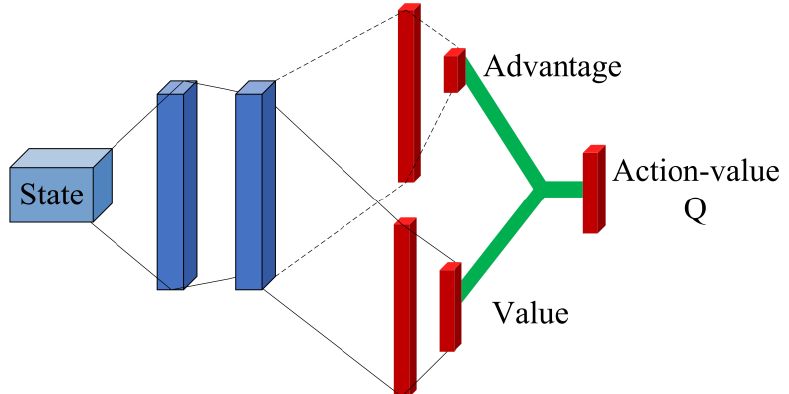
Figure 8. Paired network structure.